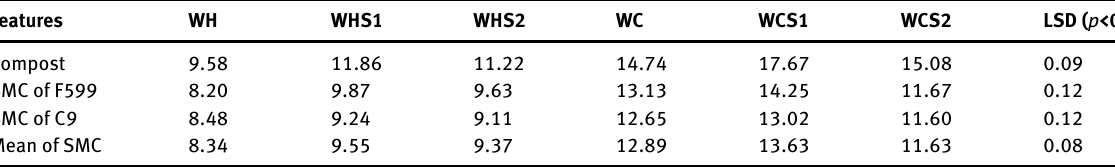
Table 6: Electrical Conductivity (EC) of composts